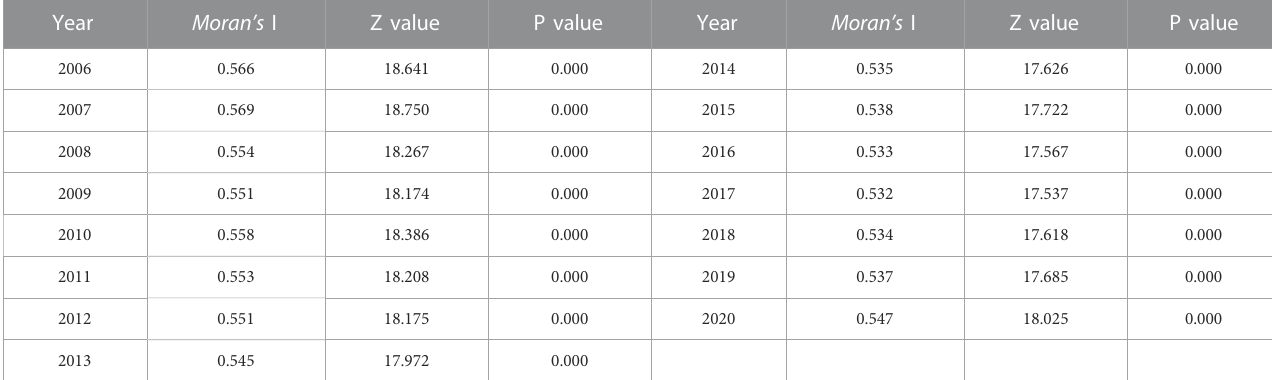
TABLE 4 Analysis results of the Global Moran index.